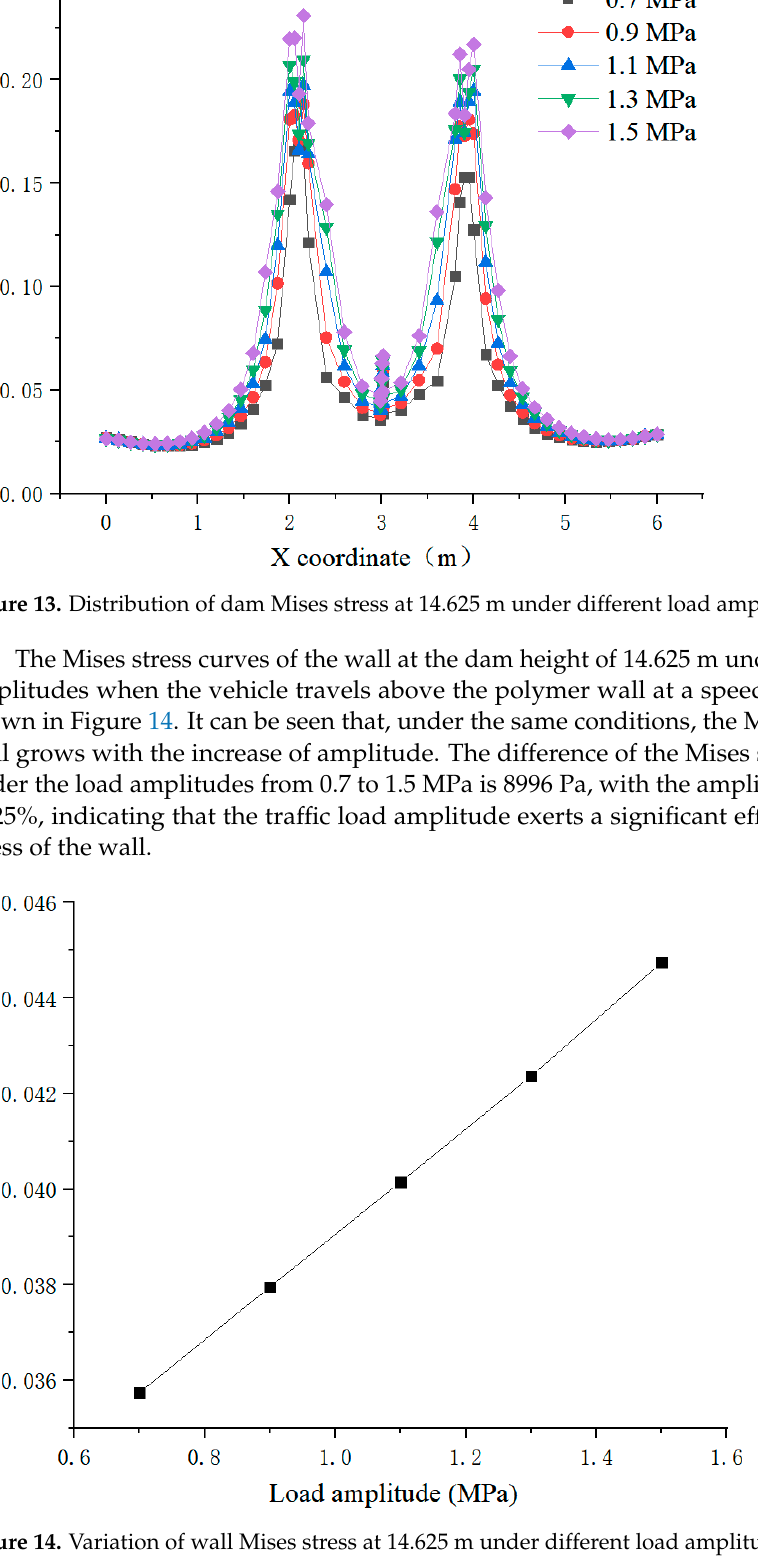
Figure 15. Distribution of displacement difference at 14.625 m under different load amplitudes. When the vehicle travels above the polymer wall at a speed of 20 km/h, the displace- ment difference curve of the wall at the dam height of 14.625 m under different load am- plitudes is shown in Figure 16. It can be observed that under the same conditions, the displacement difference enhances with the increase of the amplitude, and the displace- ment difference under the load amplitudes from 0.7 to 1.5 MPa is 0.061 mm, with the am- plitude of variation of 87.1%.